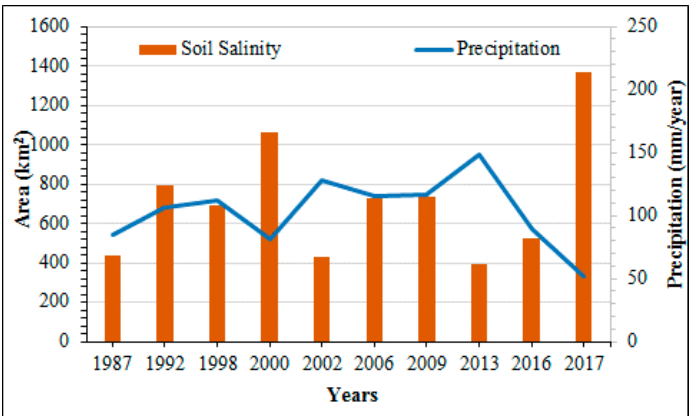
Figure 11. Relationship between areas affected by soil salinity (moderate, high, very high and extreme) and annual average of precipitation rate during 1987–2017 over the Kuwait State.